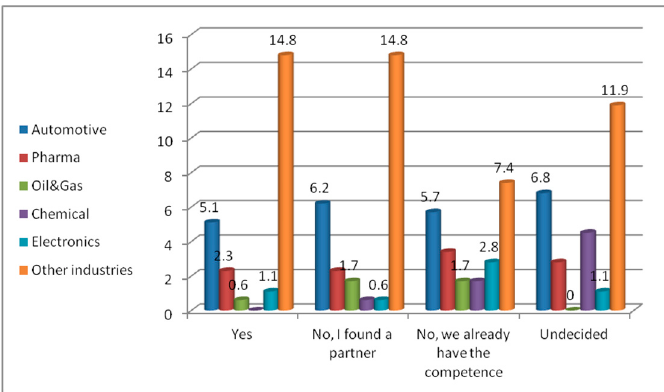
Figure 1. Distribution of answers regarding the search for solution partners for implementing technologies in relation to industry types.